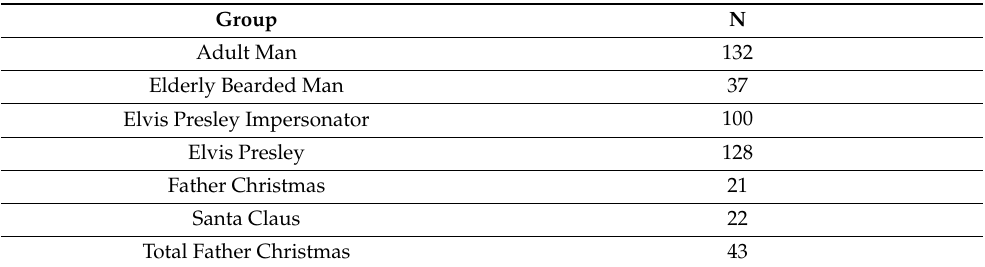
Figure 2. Receiver operating characteristic (ROC) curves for the support vector machine (SVM) classifiers trained to distinguish our groups: ( a ) Elvis Presley and Adult Man, ( b ) Elvis Presley and Elvis Presley Impersonator, ( c ) Elvis Presley Impersonator and Adult Man, ( d ) Elderly Bearded Man and Adult Man, ( e ) Total Father Christmas and Adult Man, ( f ) Total Father Christmas and Elderly Bearded Man, and ( g ) Santa Claus and Father Christmas. Areas under these ROC curves (AUC) are shown in the legends. Table 4. Groups sizes following application of inclusion and exclusion criteria and generation of facial feature vectors by